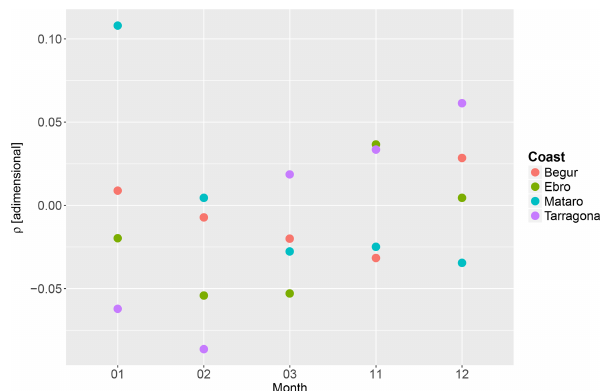
Figure 10. Copula parameters ρ of the proposed Gaussian copu- las for all considered profiles: (a) south control transect (near the Ebro Delta), (b) central-south transect (near Tarragona harbour), (c) central-north transect (near Mataró harbour) and (d) north con- trol transect (near Begur cape). The plot shows the variation with time (horizontal axis) between November 2016 and March 2017. The parameters are placed in a manner such that they start from